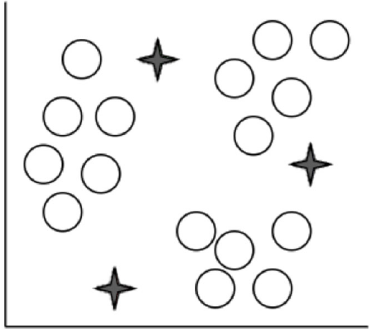
Figure 4. Step 1— K -means: K = 3 Step 1: Choose how many clusters ( K value) to be formed to group the data points.